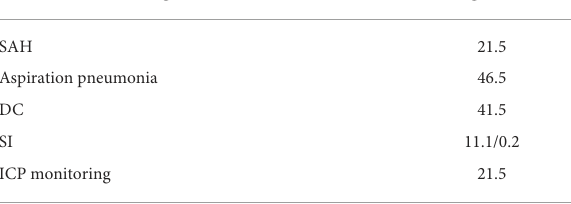
TABLE 5 A nomogram model score for predicting the risk of PTCI in patients with brain herniation.